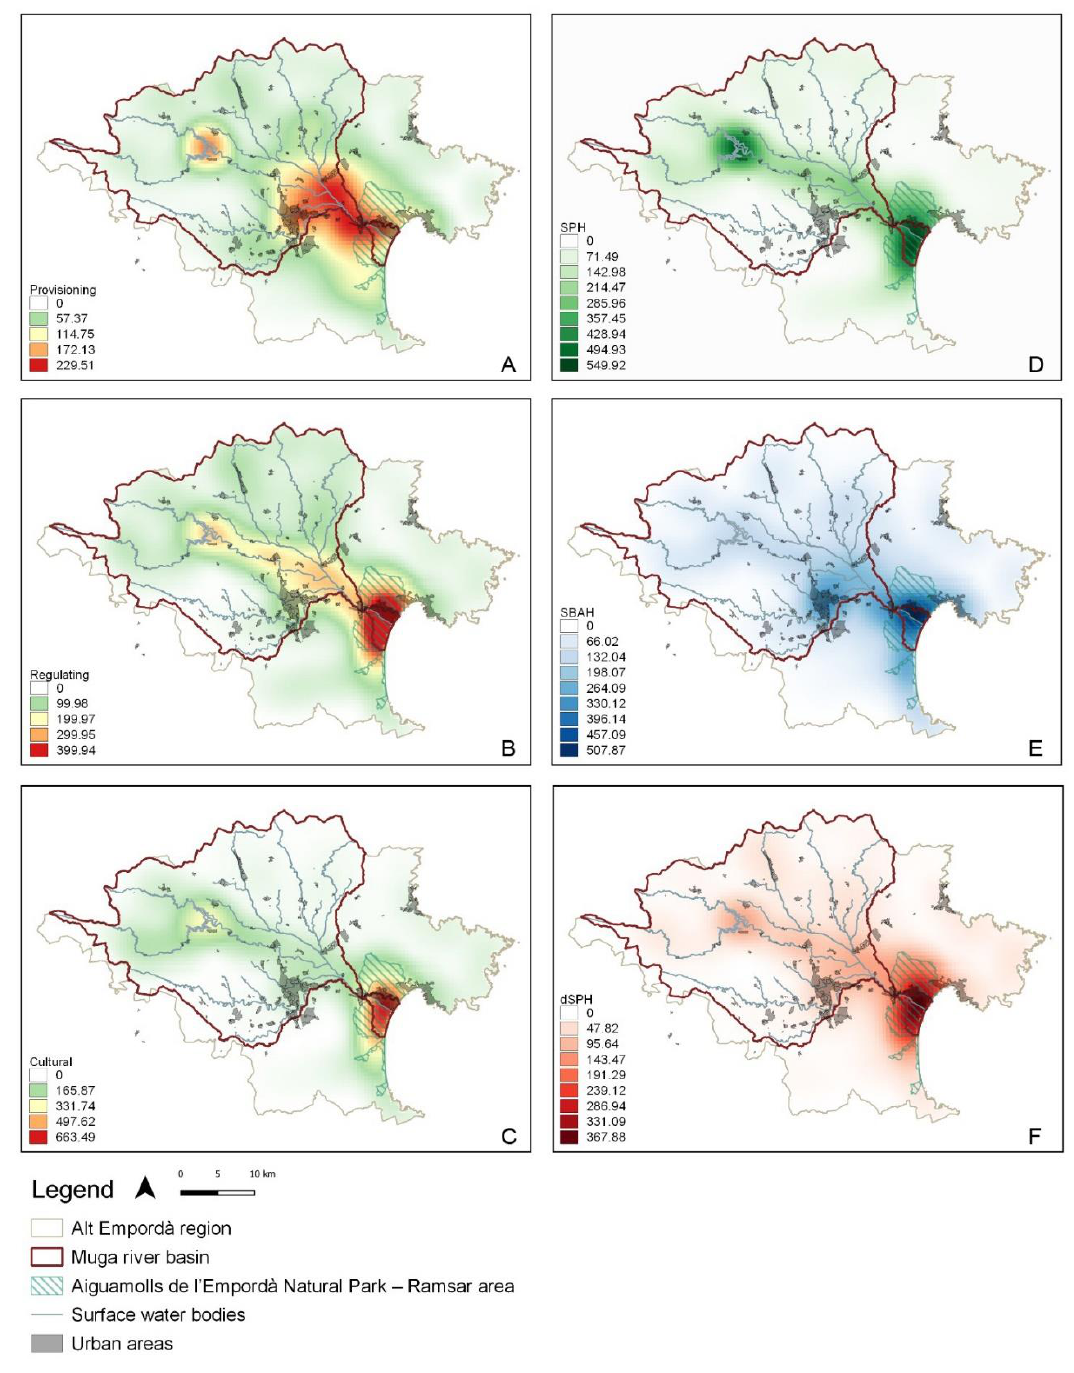
Figure 4. Intensity raster maps of water ecosystem service categories, Provisioning ( A ), Regulating ( B ), and Cultural ( C ) ( left ) and SPH hotspots ( D ), SBAH hotspots ( E ), and dSPH hotspots ( F ) ( right ) as perceived by stakeholders. SPH indicates service provision hotspots, SBAH, service benefiting areas hotspots, and dSPH, degraded service provision hotspots.